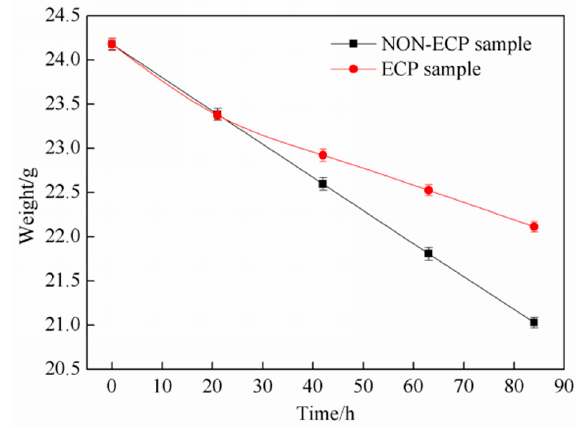
Figure 7. Relationship between weight and corroding time.